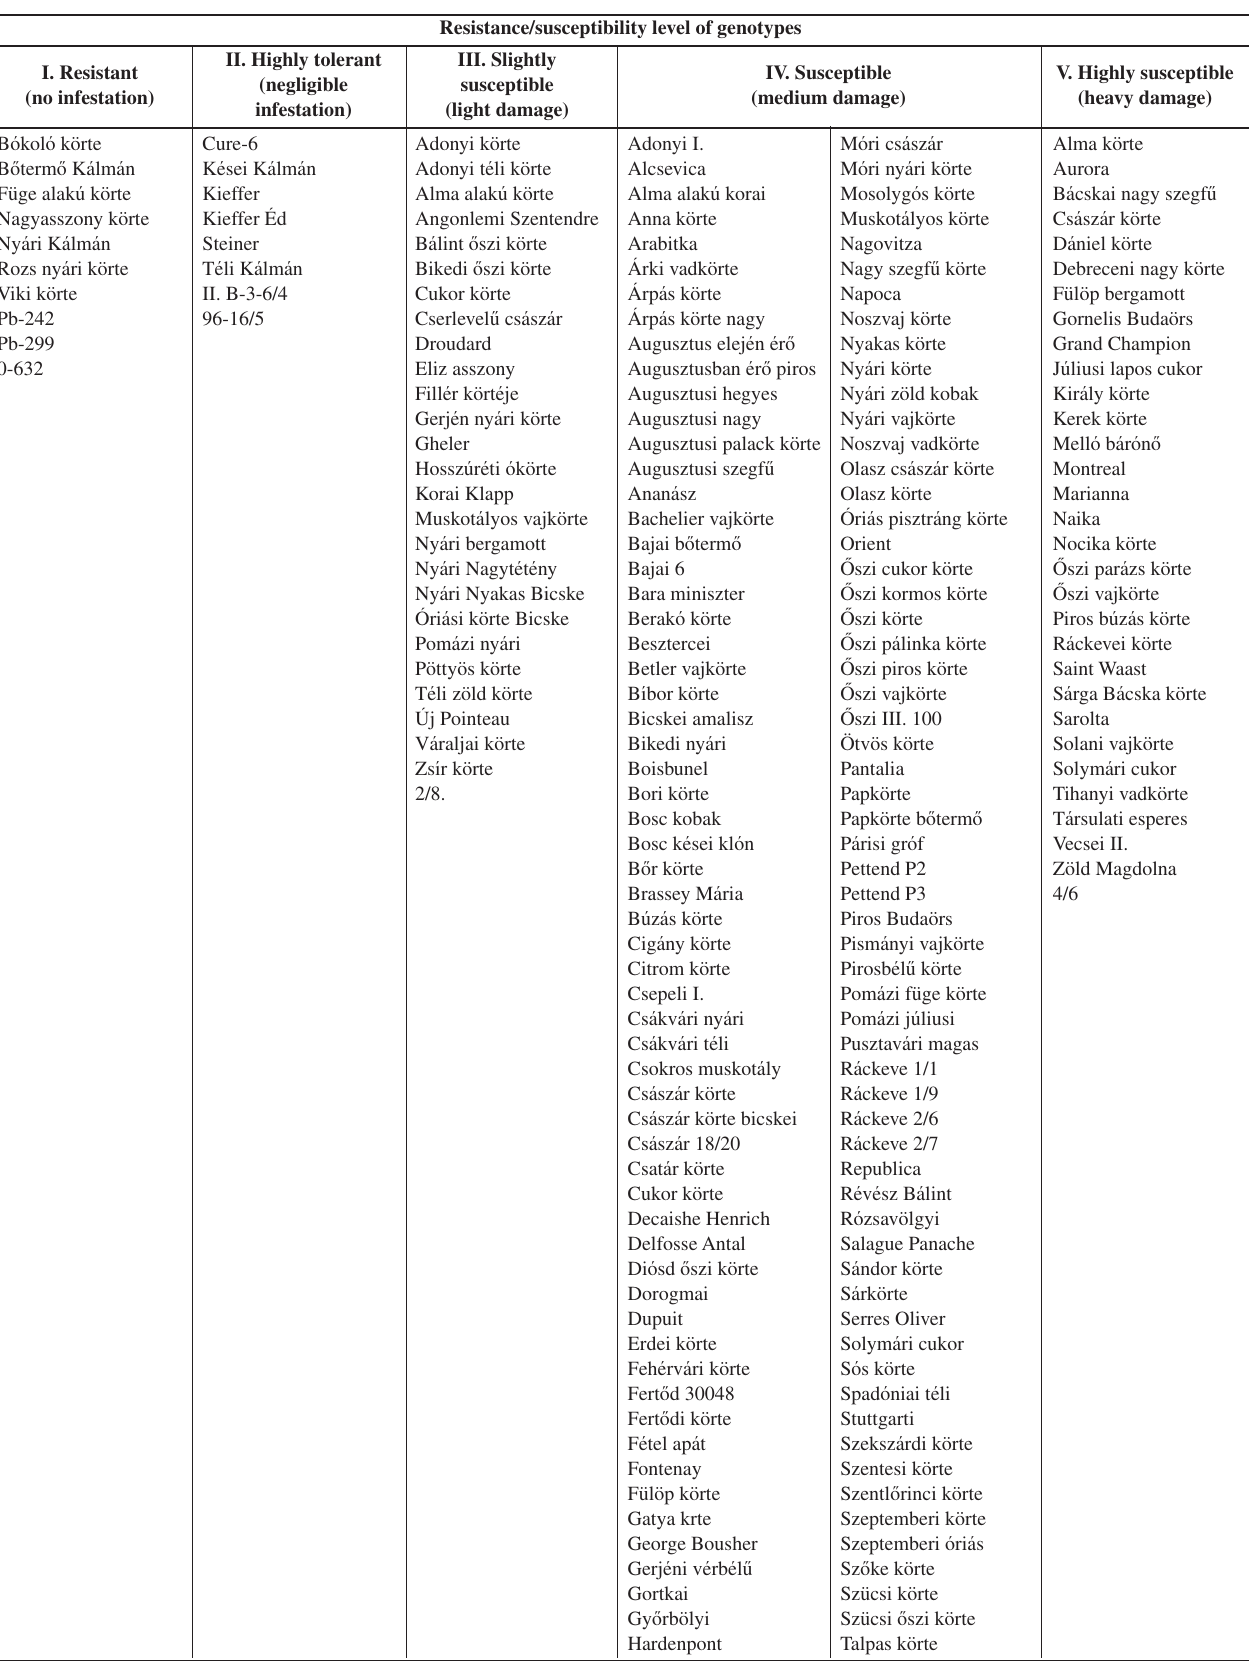
Table 1. Susceptibility of pear genotypes (commercial cultivars, ancient local varieties, unnamed local strains, seedlings, wild seedlings) to pear psylla infestation and damage (Újfehértó gene bank: 1996–1999,